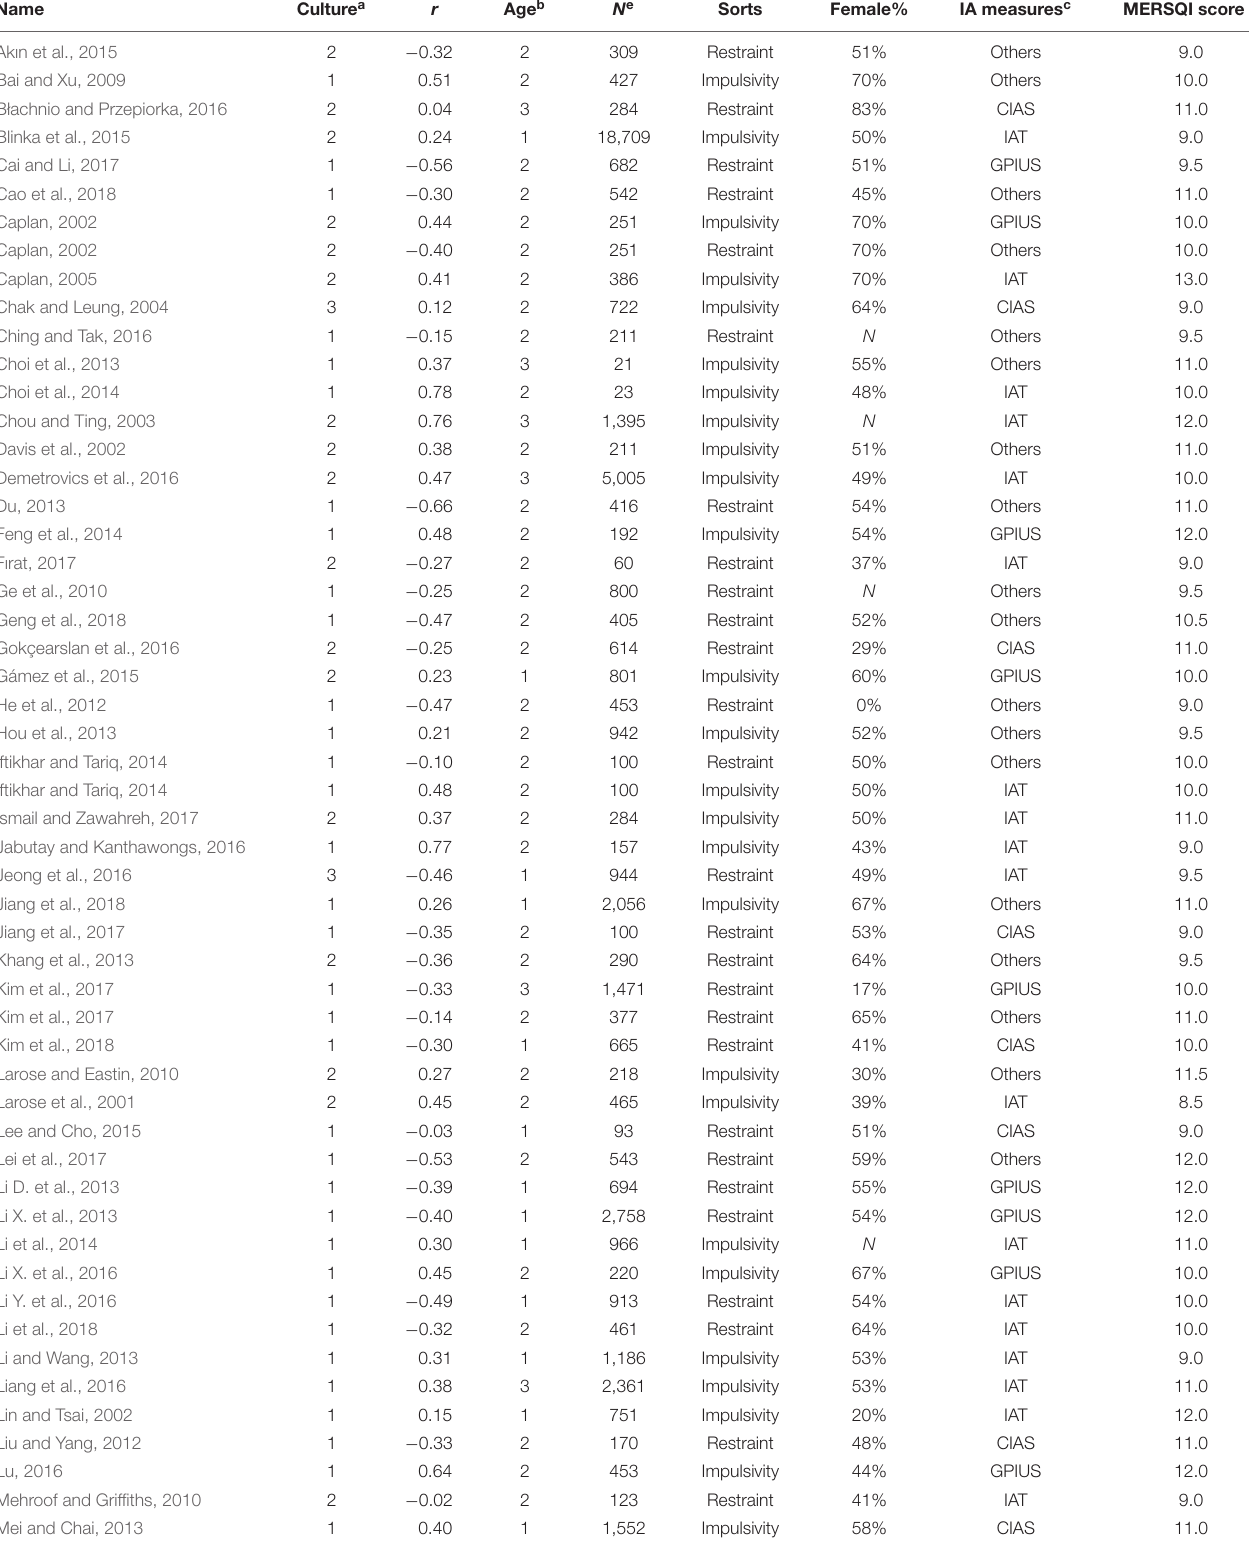
TABLE 1 | Characteristics of the 83 studies included in the